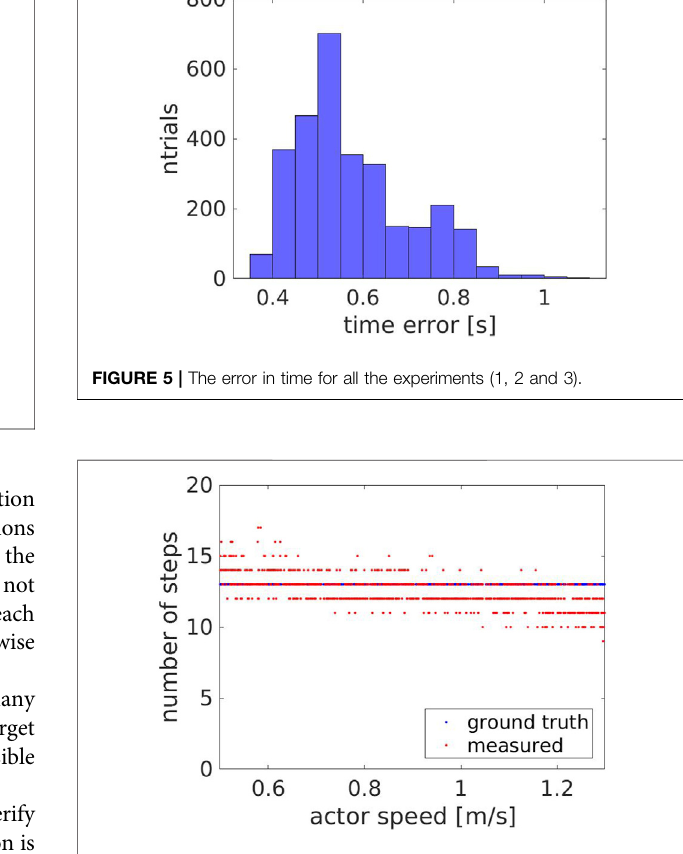
Frontiers in Robotics and AI |